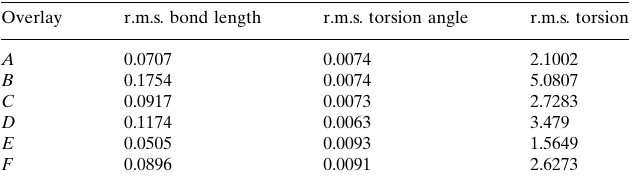
Structure matching (A˚ , (cid:1) ) between the four independent molecules. A is the structure match between molecules 1 and 2, B between molecules 1 and 3, C between molecules 1 and 4, D between molecules 2 and 3, E between molecules 2 and 4, and F between molecules 3 and 4. Overlay